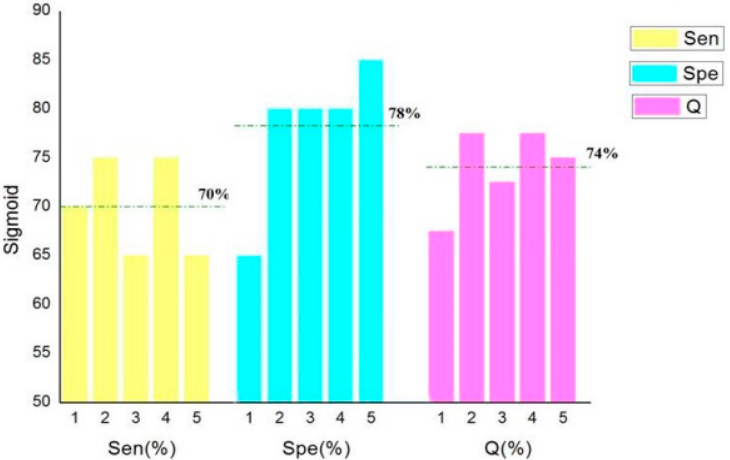
Figure 5. Cross-validation results of polynomial kernel function.